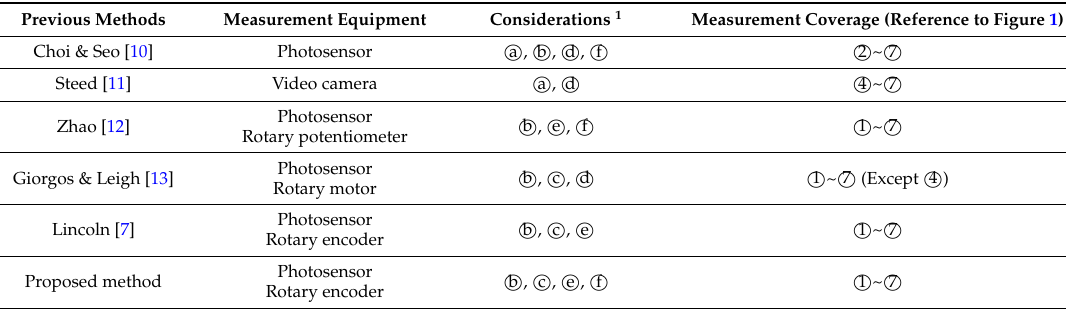
Table 1. Comparison of conventional and proposed measurement